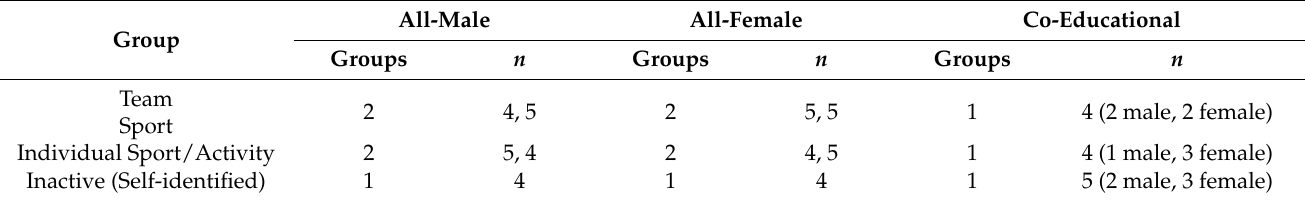
Table 1. Groupings of focus group